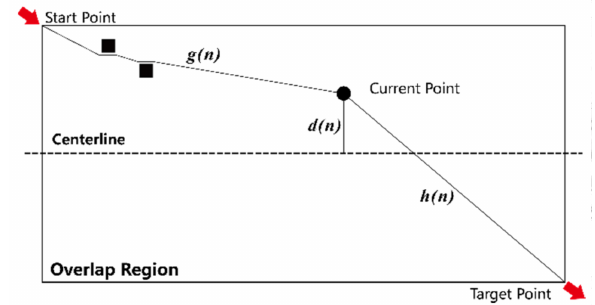
Figure 7. An illustration of each distance (or moving cost) in the search process. Black rectangle region is the overlap region of the image pair and black squares are